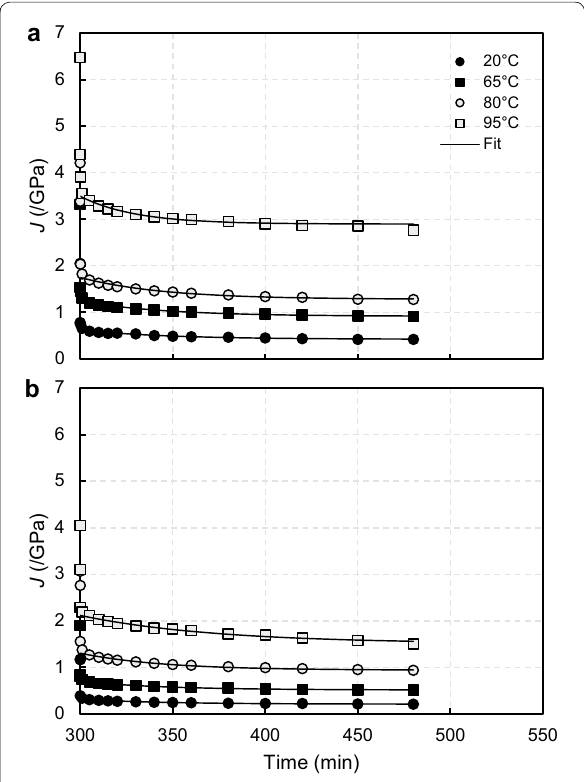
Fig. 7 Creep-recovery compliance of sugi boxed-heart timber at each temperature. a Surface-layer specimen; b inner-layer